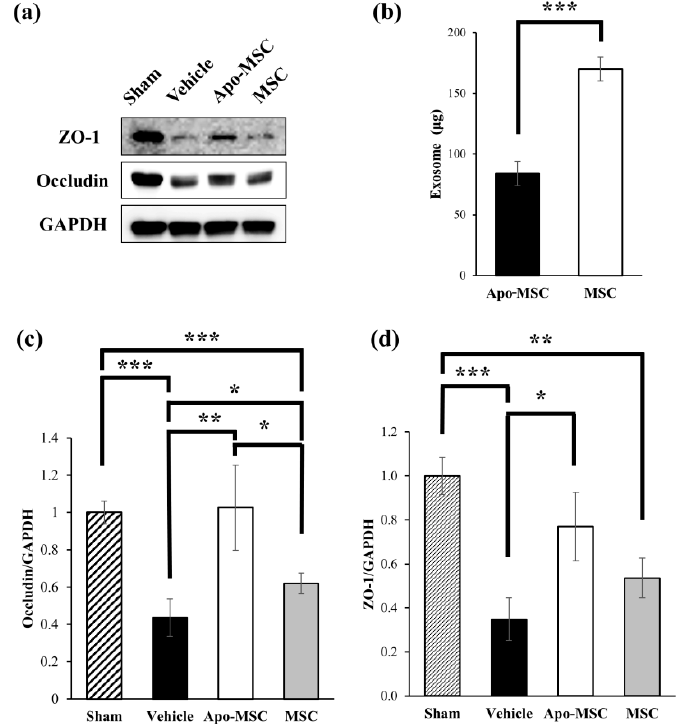
Figure 3. Effect of apocynin-preconditioned human placenta-derived mesenchymal stem cells (Apo-MSCs) and naïve MSCs on the expression of tight junction proteins in the rats at 48 h after the induction of an intracranial hemorrhage (ICH). ( a ) Results of western blotting of occludin and ZO-1 at 48 h after ICH induction. (b) Amount of exosome production. Bar graphs indicate the level of occludin ( c ) and ZO-1 ( d ) expression measured by the densitometric analysis of the bands. Glyceraldehyde 3-phosphate dehydrogenase (GAPDH) was used as a loading control. Data are mean +SD. * p < 0.05, ** p < 0.01, *** p < 0.001.